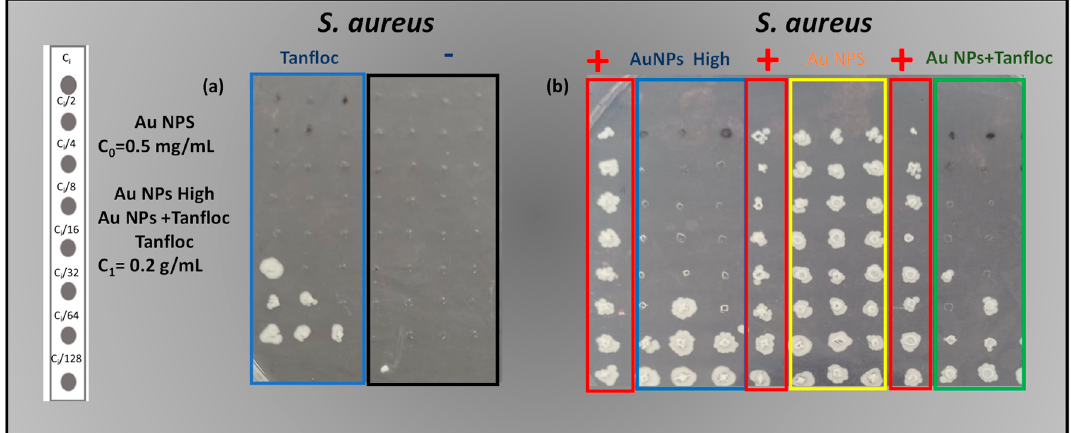
Figure 4. ( a ) Antibacterial activity (under progressive dilution) against S. aureus for Tanfloc (C 0 = 0.2 g/mL) (blue) and negative control (black); ( b ) antibacterial activity (under progressive dilution) against S. aureus for the positive control (red), Au NPs High (blue), Au NPs (yellow) and Au NPs + Tanfloc (green).